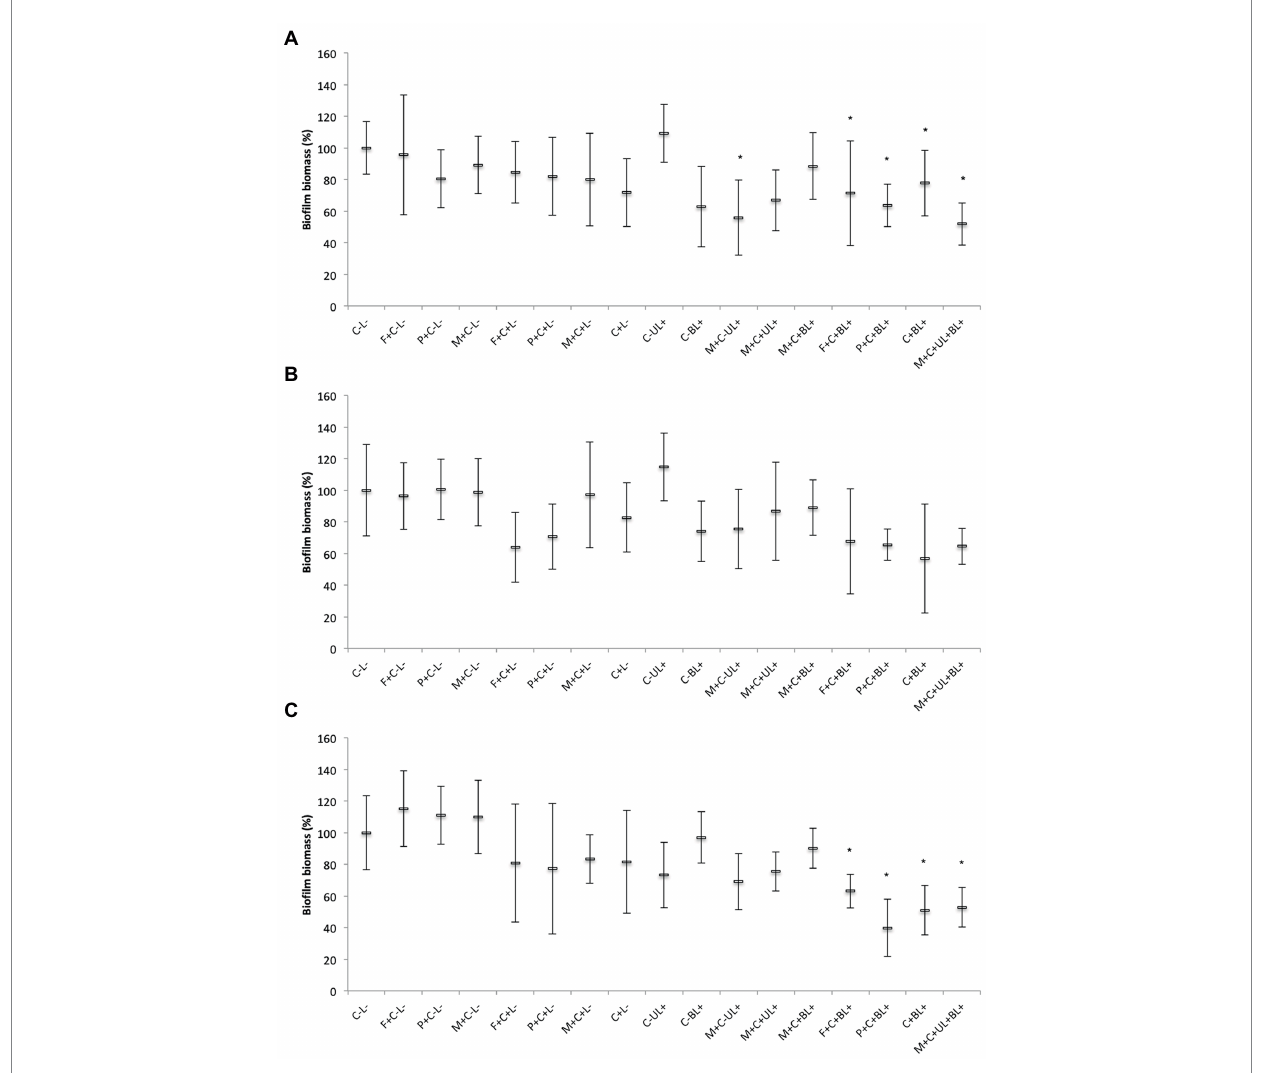
FIGURE 9 Mean values of biofilm biomass (%) of MRSA (A) , P. aeruginosa (B) , and C. albicans (C) obtained in each group of study. Error bars: standard deviation ( n = 12). Asterisks (*) denote significant differences ( p < 0.05) compared with the control (C-L-). The data was analyzed by ANOVA/Welch and Games- Howell post-hoc tests. Groups are described in the Supplementary Chart S1 of Supplementary